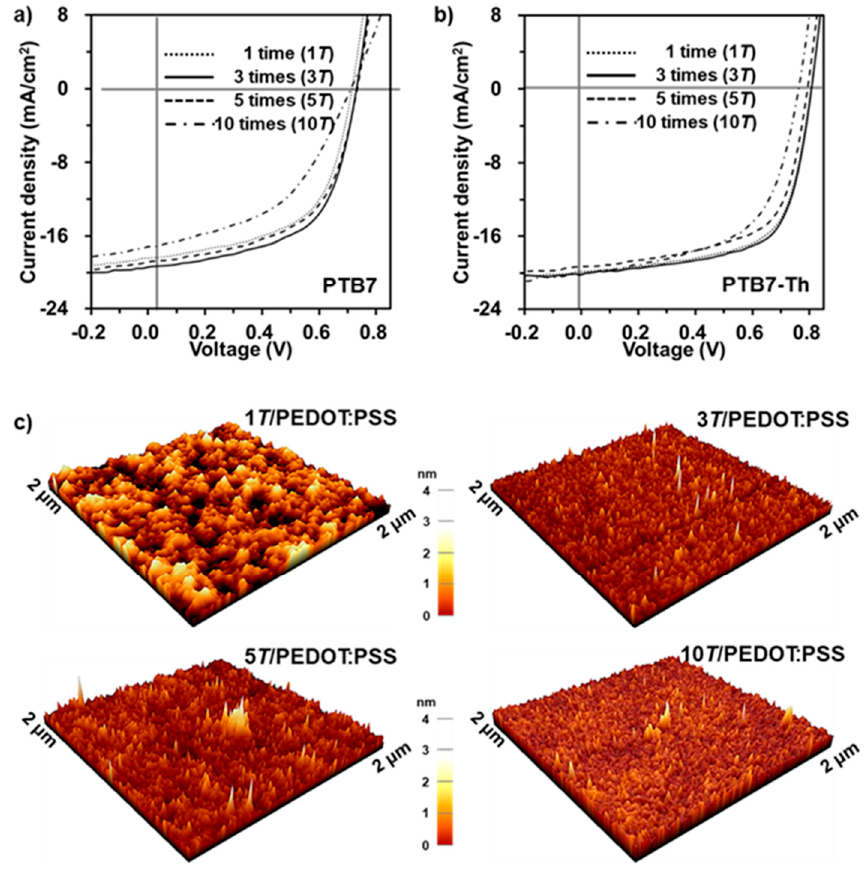
Figure 5. Device characteristics of PTB7 (PTB7 ‐ Th):PC 71 BM ‐ based OSCs with varying spin ‐ cast ‐ ing/drying cycle of the 5 ‐ nanometer MoS 2 QDs as hole ‐ transport layer. ( a , b ) J–V characteristics of PTB7 ‐ and PTB7 ‐ Th ‐ based OSCs, respectively. ( c ) AFM images of varying spin ‐ casting/drying cycles of the 5 ‐ nanometer MoS 2 QDs.